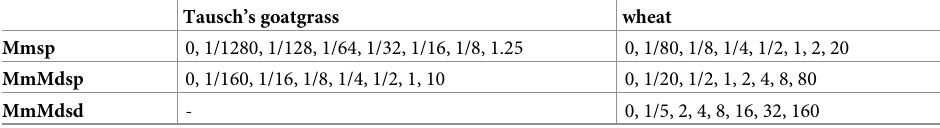
Table 1. Doses of mesosulfuron-methyl applied in each group �